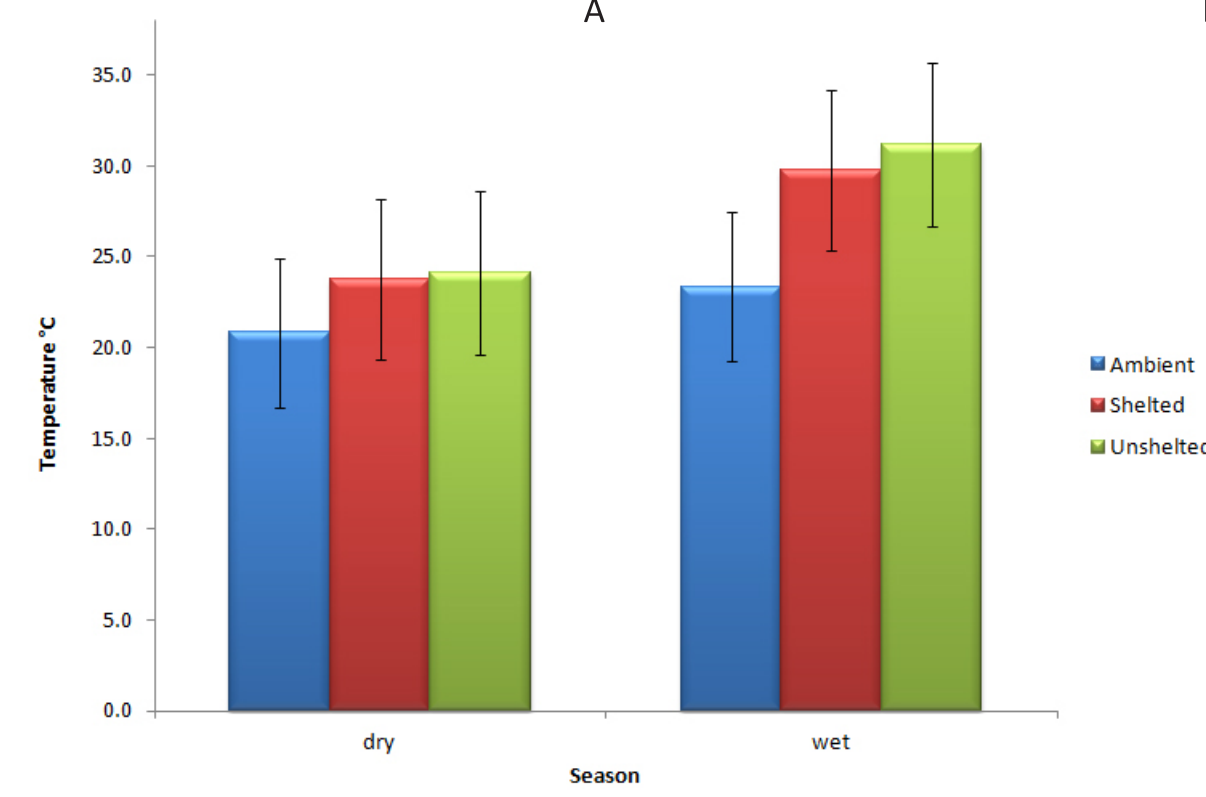
Figure 3. Temperature variation (°C) by season for the genus Crotalus